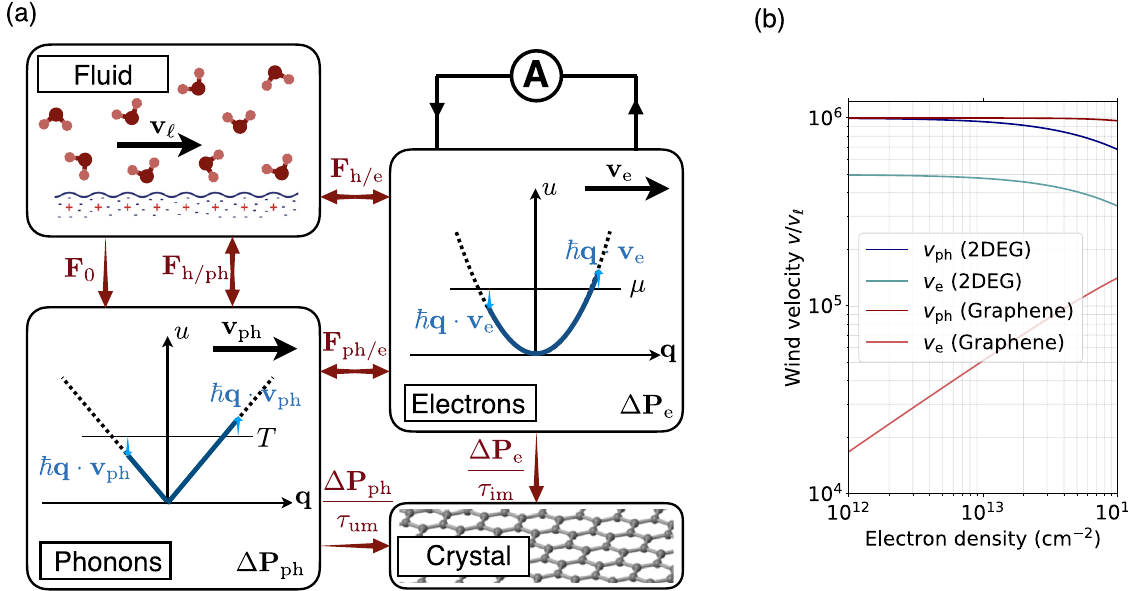
FIG. 4. Momentum balance. (a) Diagram representing the momentum fluxes in the solid-liquid system, separated into four subsystems, represented by the rectangular boxes. The liquid (flowing at velocity v l ) is a momentum source, and the “ crystal ” is a momentum sink. The momentum fluxes in and out of the phonon and electron subsystems need to be balanced in the steady state. The phonons (electrons) accumulate a momentum Δ P ( Δ P ), corresponding to a Doppler shift ℏ qv ( ℏ qv ) of their momentum e ph e ph distribution. τ is the phonon umklapp scattering time and τ is the electron impurity scattering time. (b) Phonon and electron wind um im ≈ 2 N sm − 3 and λ ¼ 2 × 10 6 N sm − 3 velocities (normalized by the liquid velocity) as a function of the electronic density, for λ 0 um